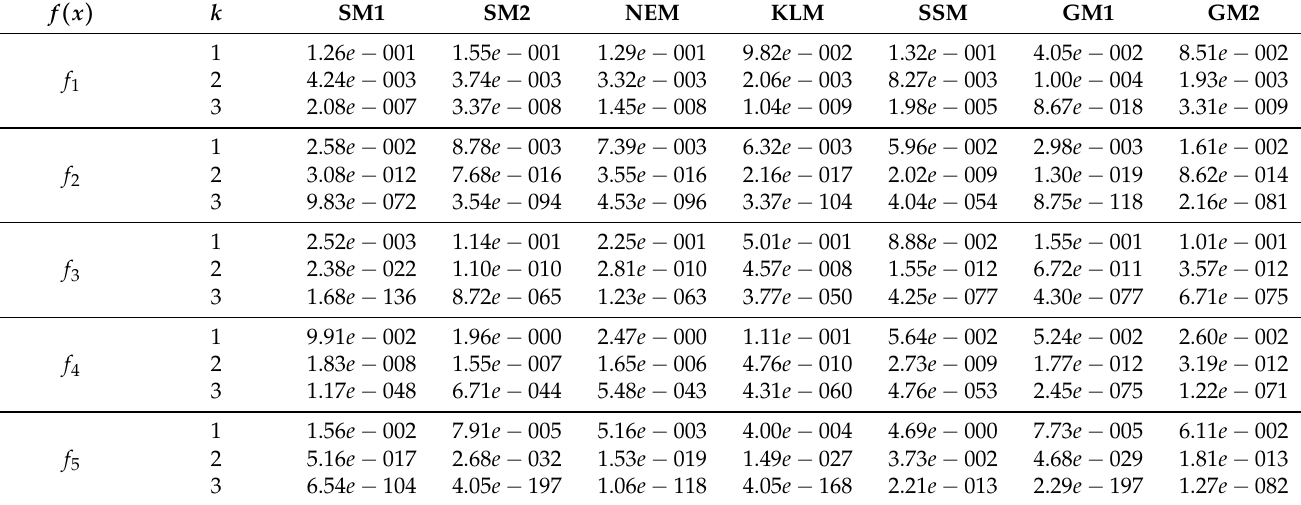
Table 5. Comparison of | f ( x k ) | for all